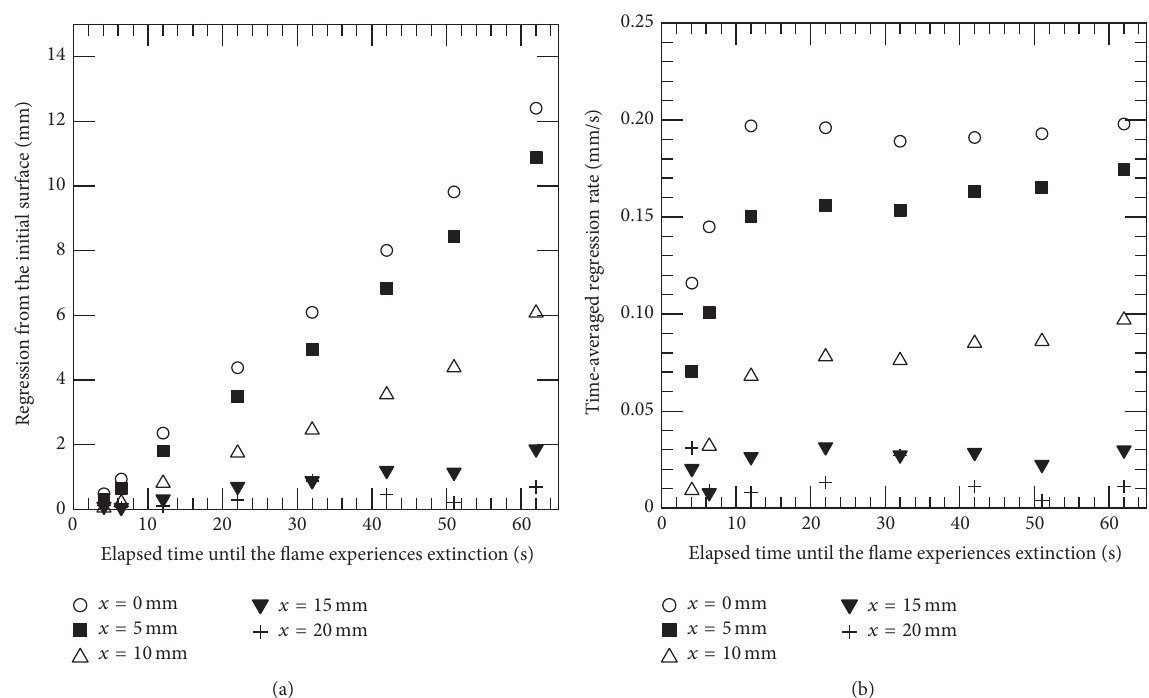
Figure 3: (a) The regression from the initial surface and (b) the time-averaged regression rate plotted against the elapsed time until the flame experiences extinction for 𝑉 = 5.6 m/s and 𝐻 = 24 mm.